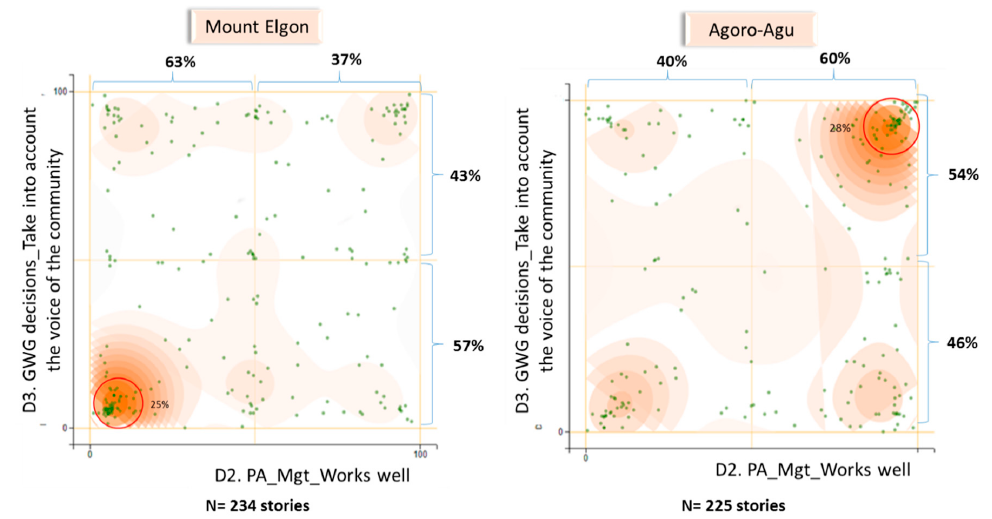
Figure 7. Relationship between landscape management and taking into account the communities’ voice. Green points locate micronarratives across the two axes and dark red shading identifies clusters of stories.